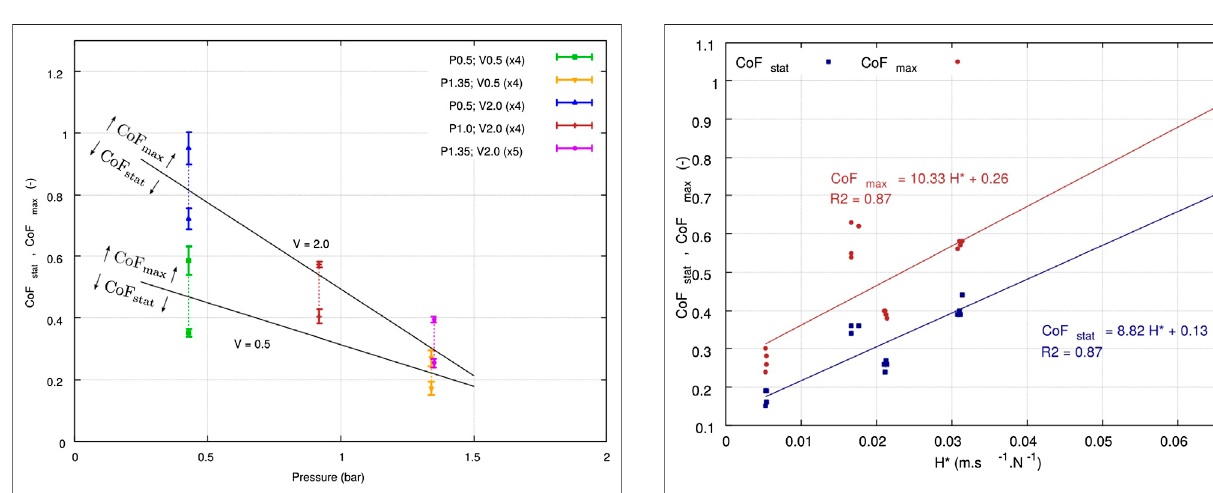
Frontiers in Materials |